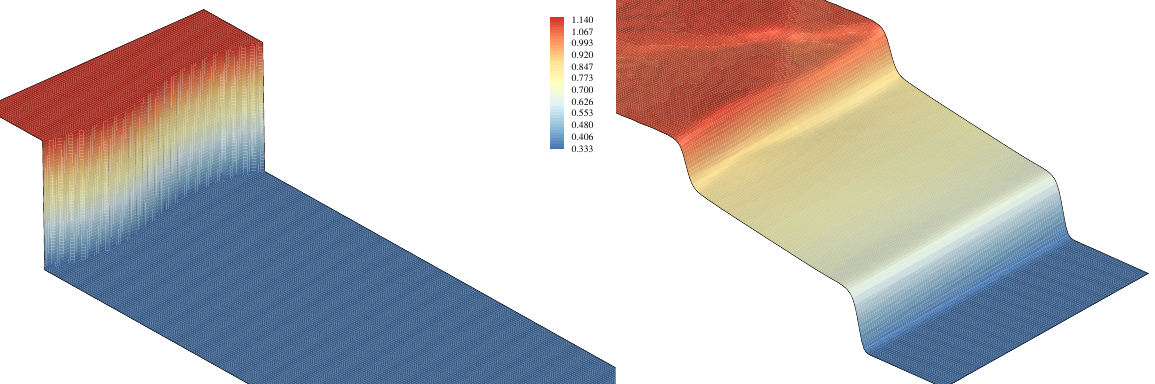
Figure 12. Case(3): Left : Initial perturbation on the shock front. Right : Evolution of the shock-front at time τ = 16.3. The shock wave has split into two travelings waves in the same direction. Both plots and their coloring show reduced density with respect to the critical value ρ / ρ cr